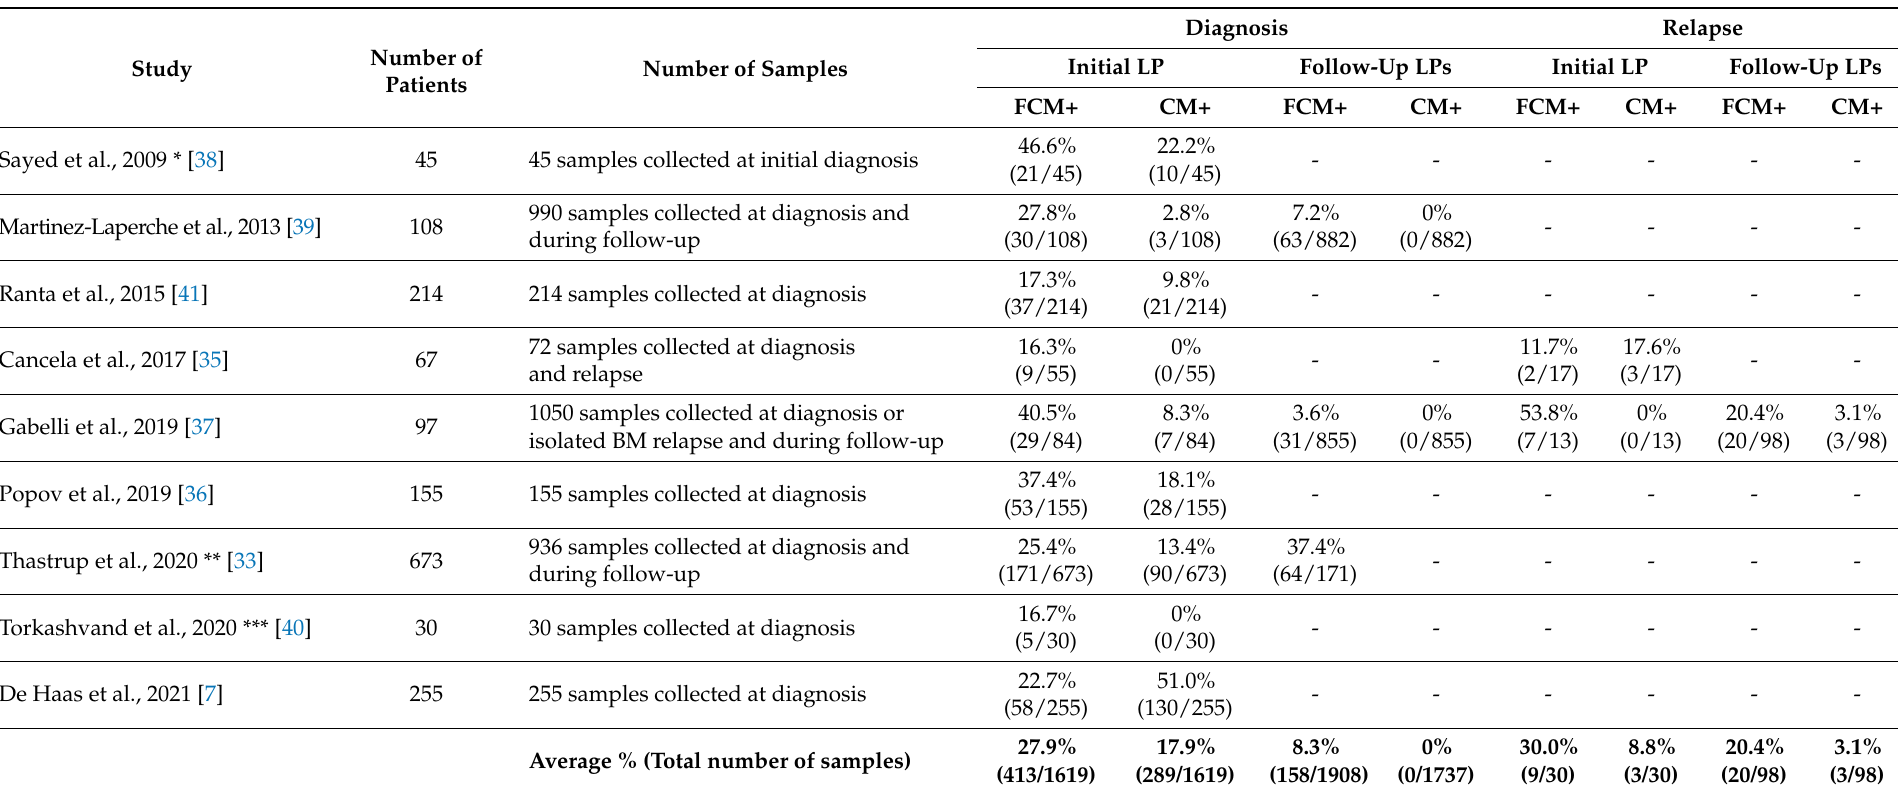
Table 2. Frequency of CNS involvement determined via flow cytometry and cytomorphology analysis in childhood ALL studies. * Twelve patients examined due to presence of neurological symptoms. Thirty-three patients examined as part of routine diagnostic work-up. Fifteen samples not analyzed via FCM due to